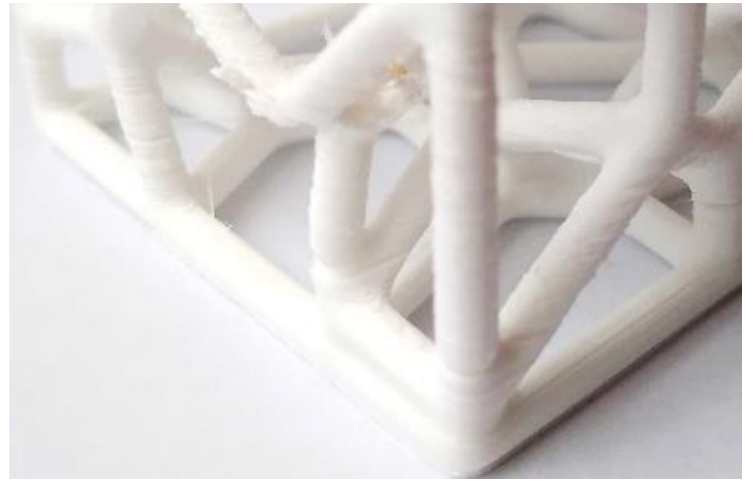
Figure 9. Long and thin trabeculae were susceptible to poor bonding and failure during 3D printing.